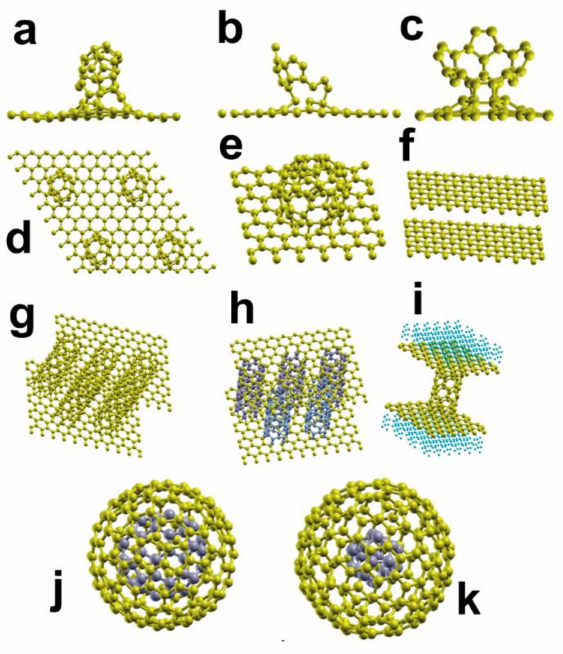
Figure 2. We present some of the hybrid carbon nanostructures reported experimentally. In ( a – d ), we have a C 30 (a buckybowl) adsorbed on graphene; in ( e ), we show a fullerene C 60 , adsorbed on graphene; we show in ( f ), a bi-layer graphene; in ( g , h ), we present pillared graphene with nanotubes (SWCNTs); in ( i ) we show pillared graphene with hydrogen; we present in ( j , k ), two examples of carbon nano onions